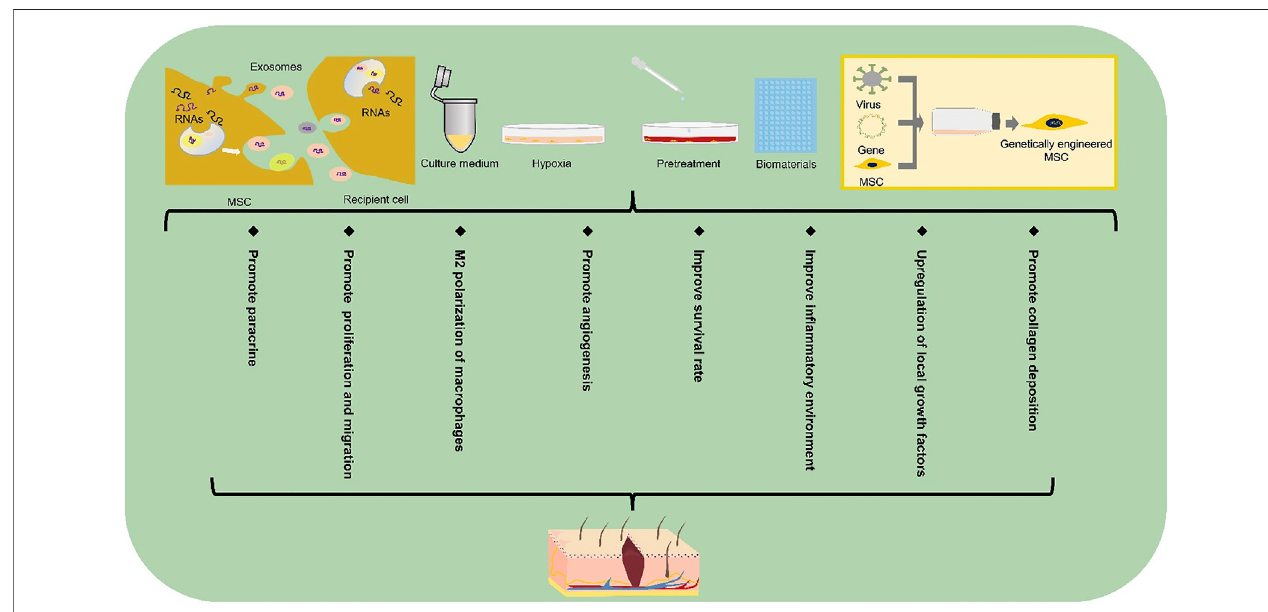
FIGURE 3 | Extended application of stem cell-based therapy in DFUs. Extended applications for stem cell repair of the diabetic foot include exosomes, gene therapy, biomaterials, culture media, pretreatment and hypoxic preconditioning. MSC, mesenchymal stem cell.